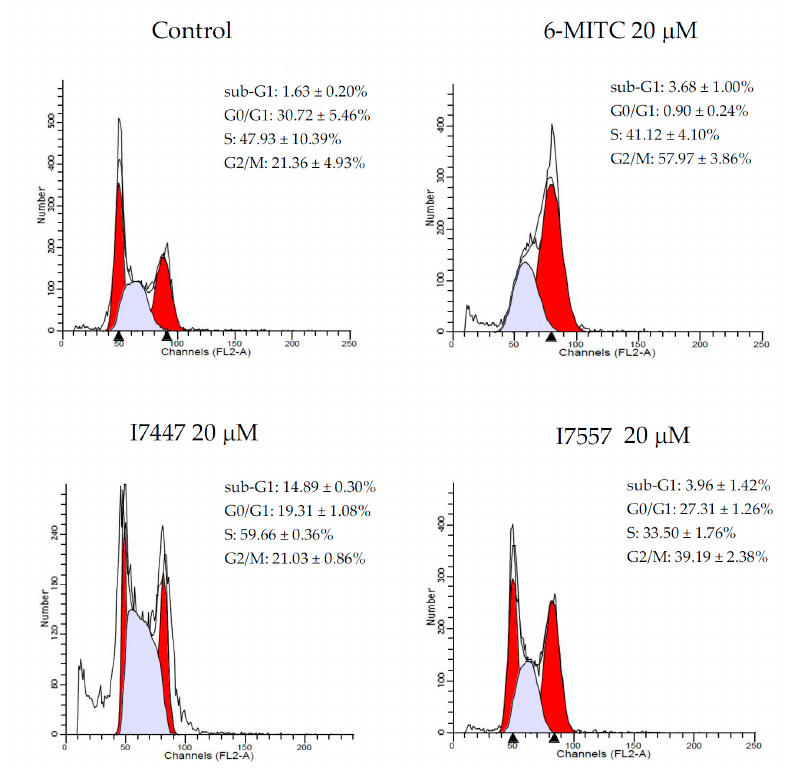
Figure 4. Cell cycle analysis of SAS cells treated with wasabi compound, 6-MITC, and its derivatives I7447 and I7557. Cells were treated with 6-MITC, I7447, and I7557 at 20 µM for 24 h. After treatment, cells were fixed and stained with propidium iodide. Cell cycle distribution was acquired by flow cytometry. Representative DNA histograms of SAS cells, treated with the three compounds, were shown, and the expression level of each cell cycle phase was indicated in the panels. Data from the three separate experiments were expressed as the mean ± SEM.